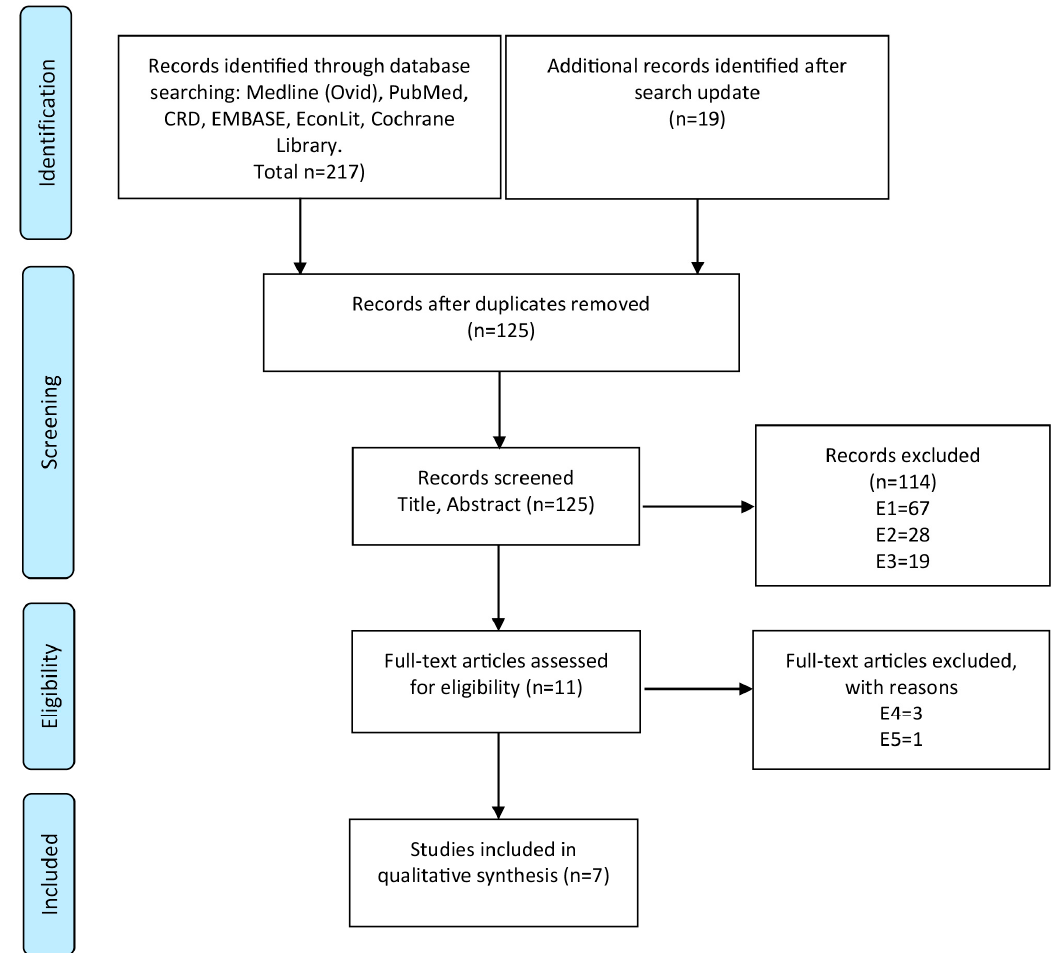
Figure 1. PRISMA flow diagram for the process of literature search and exclusion: Electronic data bases were searched for cost-effectiveness studies evaluating endometrial cancer screening and/or prevention strategies. Numbers of excluded studies are listed for each reason of exclusion. Exclusion criteria: E1—other diseases than endometrial cancer or already have endometrial cancer, recurrent cancer or metastases; E2—studies evaluating cost-effectiveness of other interventions (e.g., therapy of endometrial cancer); E3—not decision-analytic modelling studies; E4—not full health-economic studies (cost-effectiveness studies); E5—editorials, reviews, abstracts; E6—not in German or English language.